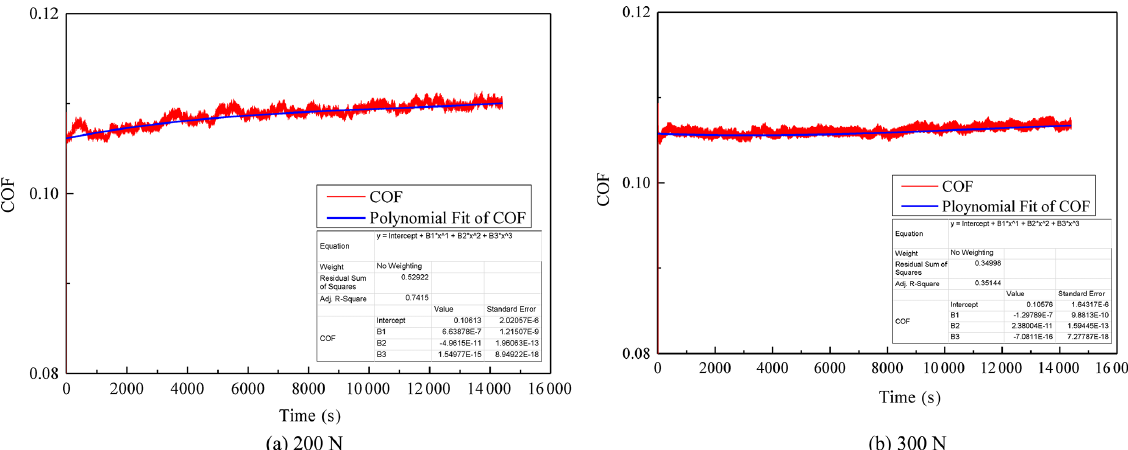
Figure 16. The COF evaluation curve after 4h of testing under different